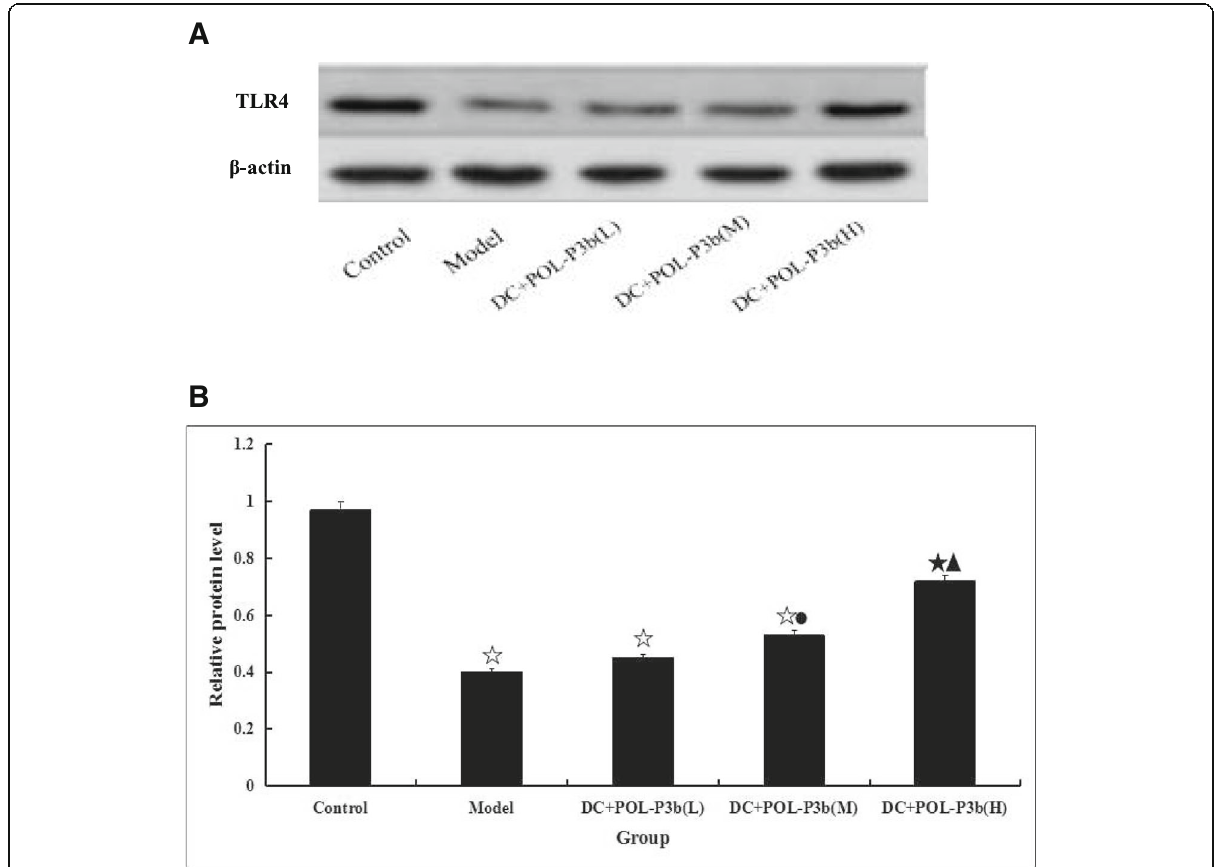
Fig. 3 The expression of TLR4 and β -actin in intestinal DC a Western blot analysis showing the expression of TLR4 in intestinal DC isolated from U14-bearing mice treated with oral POL-P3b. b Statistical bar graph of expression of TLR4 protein. Immunoblots were scanned within the linear range and quantitated using the computer software. The quantitated values represent the mean ± S.D. compared with control, P < 0.05, ☆ P < 0.01; compared with model, ● P < 0.05, P <